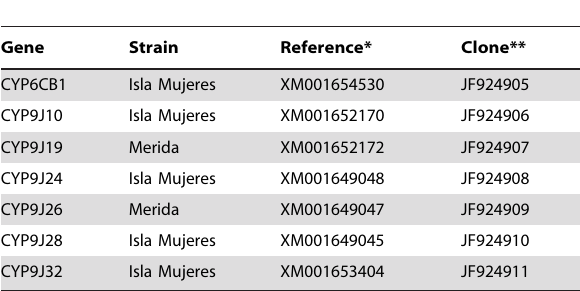
Table 1. Accession numbers for P450